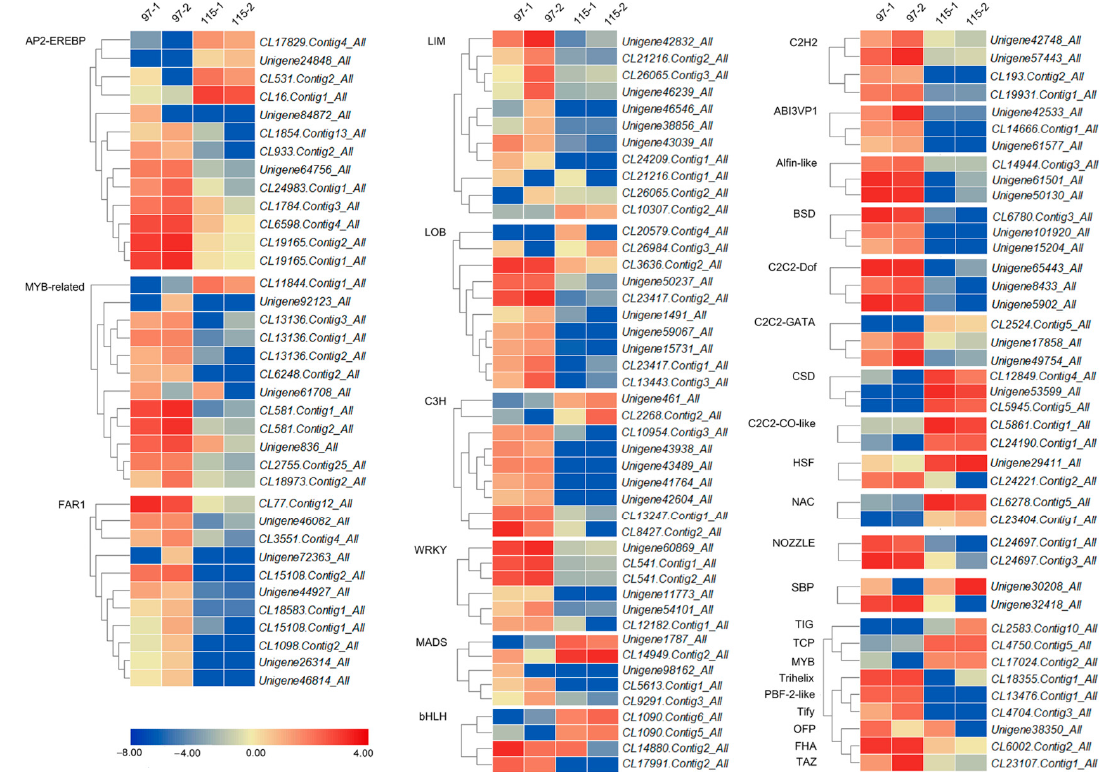
Figure 6. Heatmap of 122 differentially expressed TFs. The bar represents the expression (FPKM) level of each gene in 97-1, 97-2, 115-1, and 115-2 as indicated by red/blue rectangles, the deeper color indicates the higher/lower expression. The number next to the color bar on the right side refers to the Log 2 value of the FPKM.